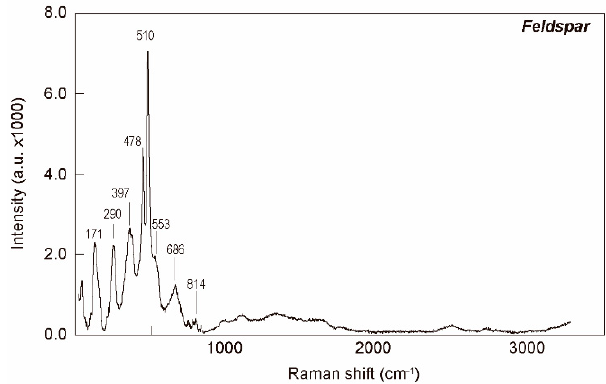
Figure 5. Raman spectra of plagioclase.